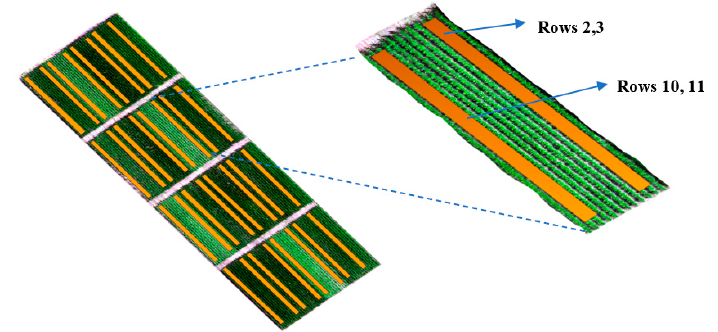
Figure 5. The spatial location of rows 2, 3, 10, and 11.